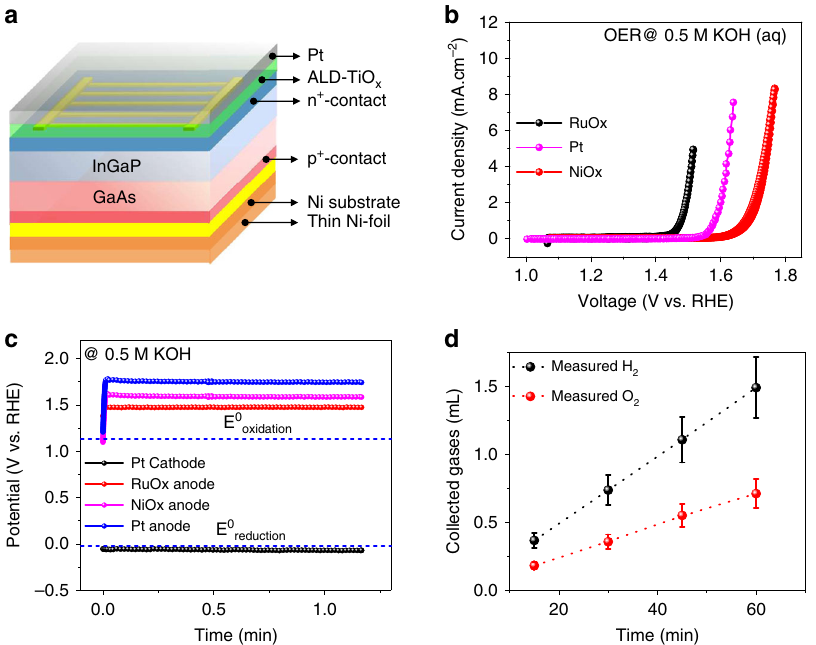
Fig. 4 Wireless device structure and demonstration. a The device structure employed for the wireless con fi guration. b CV curves used to obtain the electrocatalytic overpotential values of the HER/OER catalysts for the Pt/Pt, Pt/RuOx, and Pt/NiOx electrodes in 0.5 M KOH (aq). c Chronopotentiometry experiments at a current density of 10 mA cm − 2 . d The O 2 and H 2 volumes measured for the device without any electrical